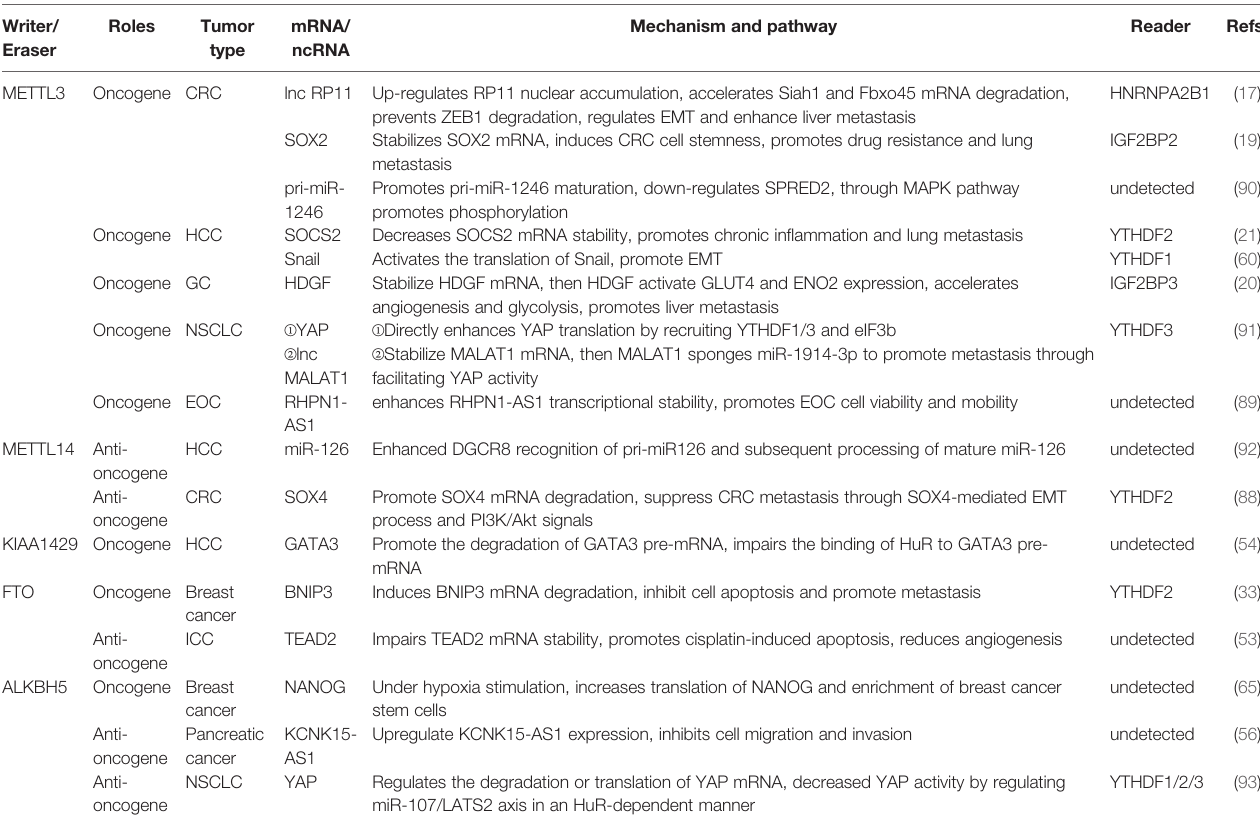
TABLE 1 | Roles of key m 6 A members in the metastasis of various cancers. Writer/ Eraser